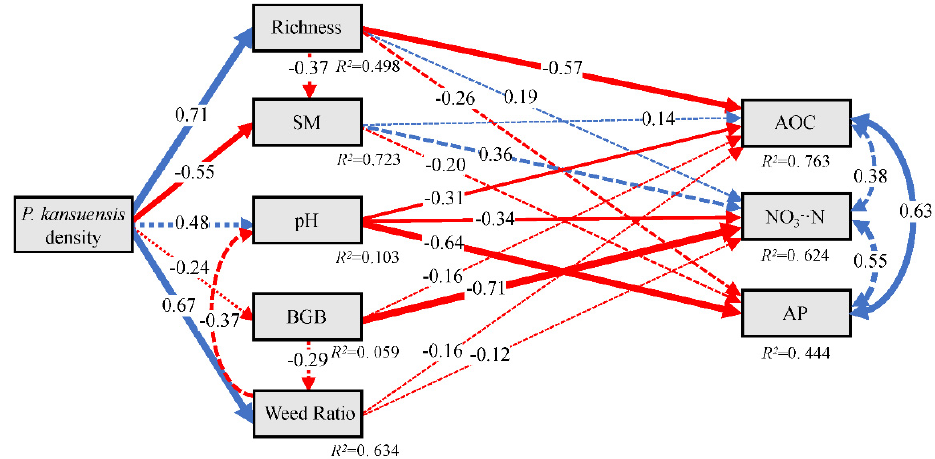
Figure 7. SEM of the mechanisms that related indicators affecting soil nutrients. The direction of the arrow indicates causality, the number on the arrow represents normalized path coefficient, and line thickness is positively correlated with significance; the solid blue line indicates a positive and sig- nificant relationship, the solid red line indicates a significant negative relationship, and the dashed line indicates a non-significant relationship. In the figure: treatment means three stages of P. kan- suensis expansion; Richness means species richness; Weed Ratio means the weed ratio; BGB means belowground biomass; SM means soil moisture; pH means soil pH value; AOC means soil active organic carbon; NO 3 − ·N means soil nitrate nitrogen; and AP means soil available phosphorus. 4. Discussion 4.1. Community Characteristics and Biomass In the process of alpine grassland degradation, the total community coverage is usu- ally regarded as an essential indicator of the degradation stage [26], as is the emergence and expansion of some poisonous weeds [27,28]. In our study, however, we found that in the process of P. kansuensis expansion, the total community coverage did not change sig- nificantly, but the community composition and structure had changed. Among them, the richness index and Shannon–Weiner index increased significantly, indicating that the community was in a moderate degradation stage [12]. The growth and spread of the Weed group, P. kansuensis included, led to an increase of species number in the community, which reflected the rise and fall of different populations in the process of degradation and succession [12,26]. In terms of plant biomass, the AGB and BGB of the HD patches were reduced by 37.05% and 13.99% compared with the CK patches, respectively, which is con- sistent with previous research results [10,29,30], indicating that species richness and di- versity indexes may temporarily increase after the invasion, but their biomass declines slowly. This may attribute to the reduction of the thickness and density of the grasses, the gradual vacancy of the ecological niches, and the decline of high-quality edible grasses such as the Gramineae [12,27,31]. The hemi-parasitic plant P. kansuensis obtains water and nutrients from the host plants by its haustoria to promote its growth [32], but it has a strong host preference [33]. In our study, the ABR of the Gramineae decreased by 15.61% in the HD patches and the ABR of the Cyperaceae by 15.45% in the LD patches, indicating that P. kansuensis may have been parasitized on the Gramineae during the early stages of the expansion, and absorbed a lot of water and nutrients in the subsequent expansion, leading to a rapid decline of the AGB of the Gramineae, which is similar to a study in Bayanbulak grassland [21], while the Cyperaceae may undergo this process during the